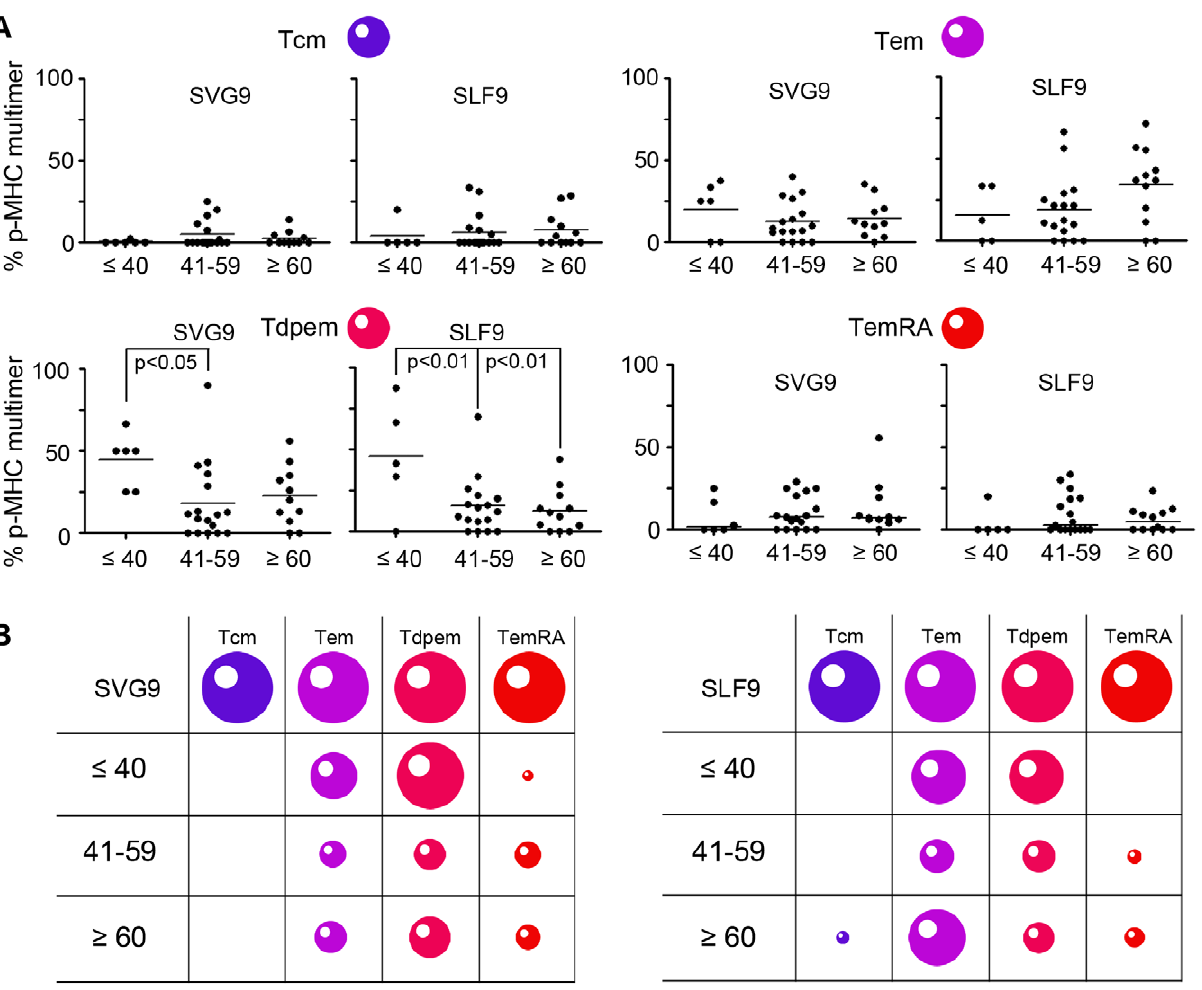
Figure 5. Distinct Phenotype of SGV9 and SLF9 specific cells correlate with donor age. (A) Memory phenotypes of antigen experienced T cells from donors separated by age group are shown, based on expression of CD27, CD45RA, CCR7, CD57 as defined in Table 2. For data of a normal distribution, lines represent mean values and p values are from a student t-test analysis. For data of a non-normal distribution, lines represent median values and p values are from a Mann-Whitney test. (B) The size of each cell represents the median percentage of the prevalent memory phenotypes for each age group.